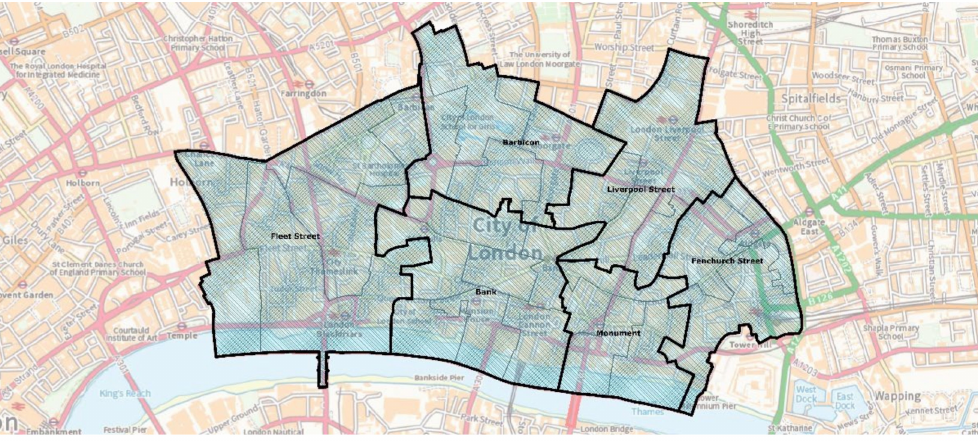
Figure 3. Map of the clusters in the City of